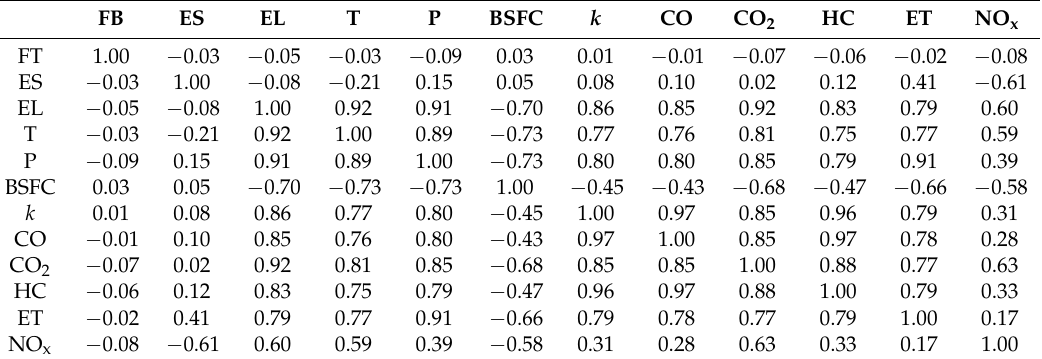
Table 5. Evaluated parameter correlations ( R